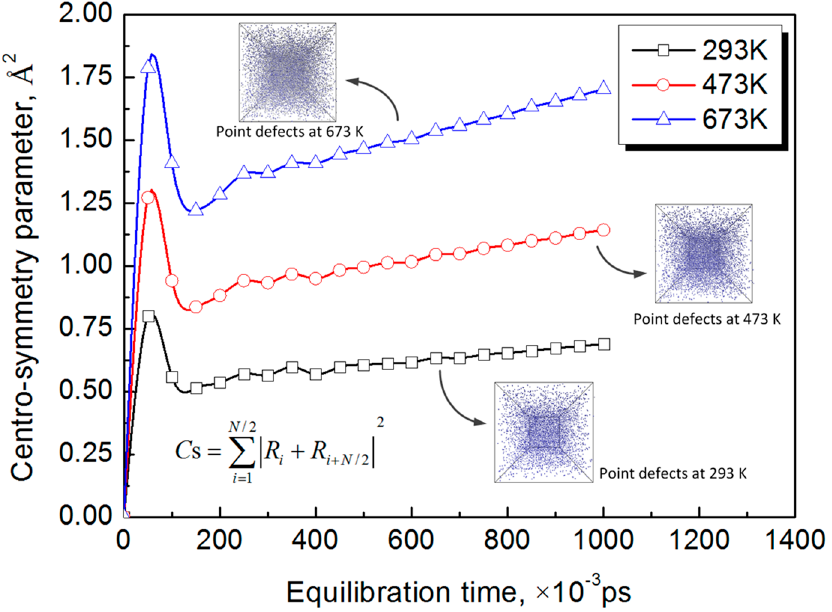
Figure 10. Centro-symmetry parameter as a function of equilibration time under different temperatures.